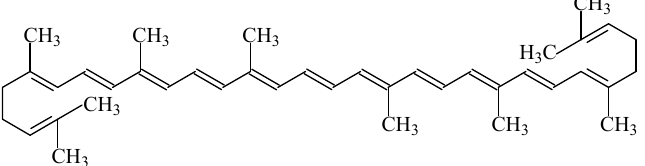
Figure 8. Structural formula of lycopene (E160d).